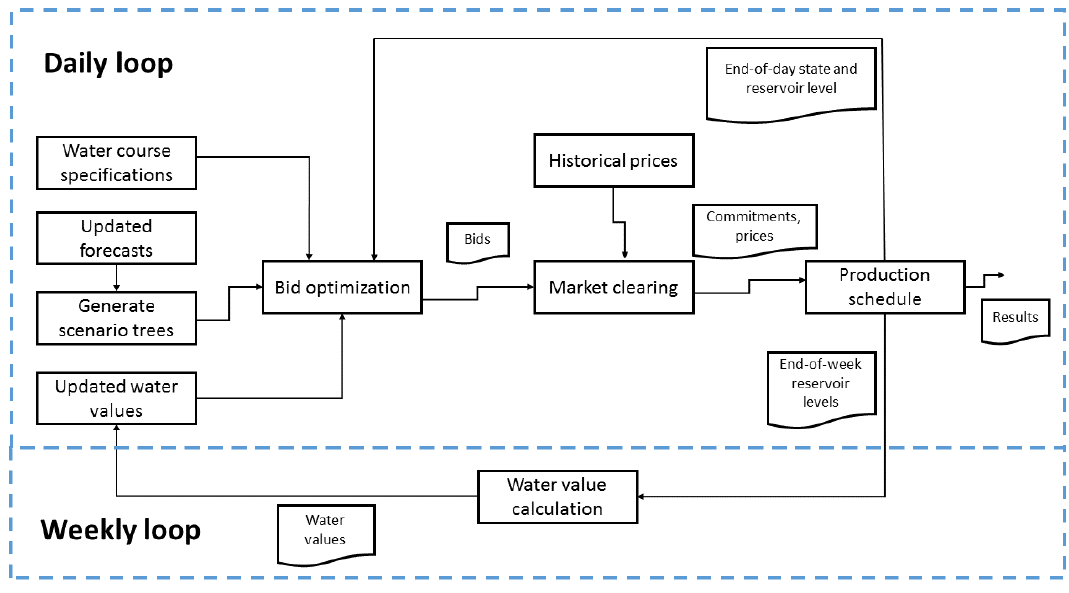
Figure 4. Flow-chart for the simulation